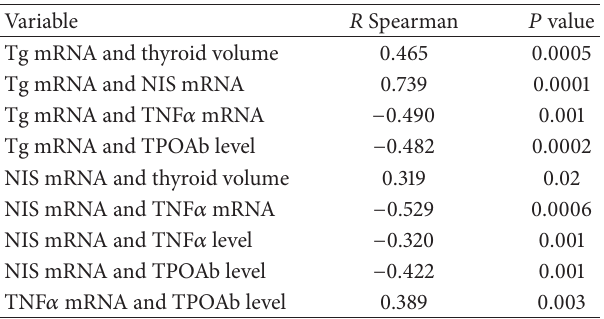
Table 3: Spearman’s correlation coefficients of gene expression and other variables studied in patients with Hashimoto’s